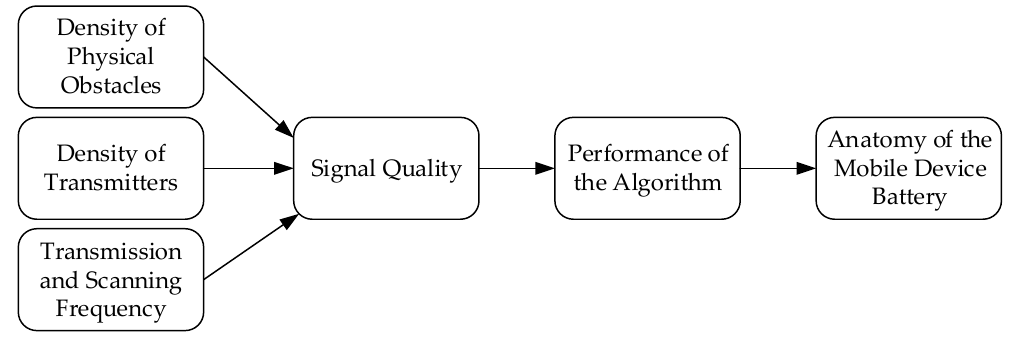
Figure 2. The conceptual research model.